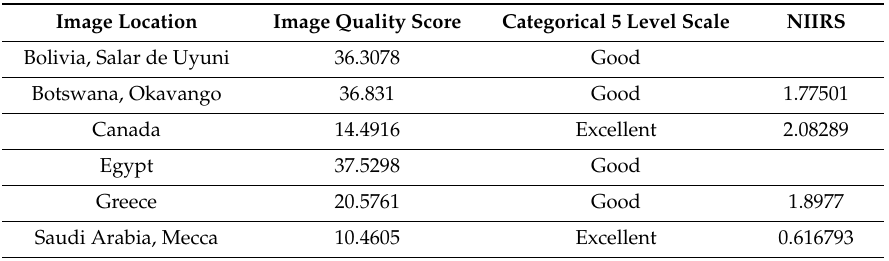
Table 1. nSight-1 image quality and interpretability